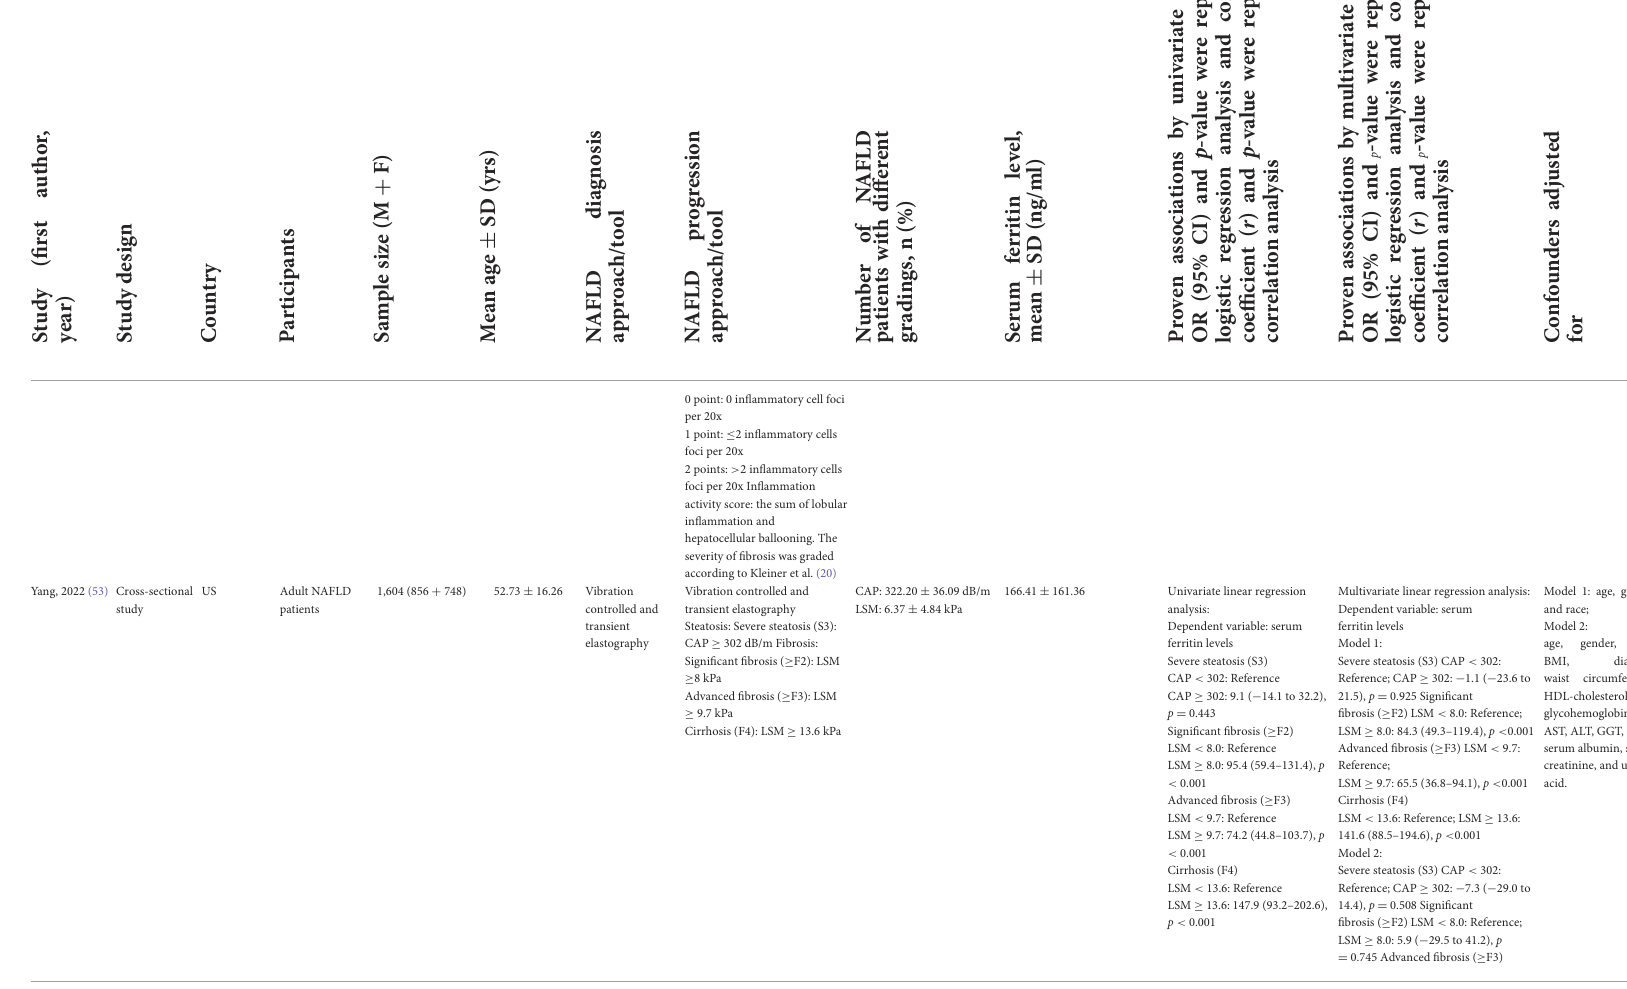
Multivariatelinearregressionanalysis: Dependentvariable:serum ferritinlevels Model1: Severesteatosis(S3)CAP < 302: Reference;CAP ≥ 302: − 1.1( − 23.6to 21.5), p = 0.925Significant LSM ≥ 9.7:65.5(36.8–94.1), p < 0.001 Cirrhosis(F4) LSM < 13.6:Reference;LSM ≥ 13.6: 141.6(88.5–194.6), p < 0.001 Model2: Severesteatosis(S3)CAP < 302: Reference;CAP ≥ 302: − 7.3( − 29.0to 14.4), p = 0.508Significant fibrosis( ≥ F2)LSM < 8.0:Reference; LSM ≥ 8.0:5.9( − 29.5to41.2), p = 0.745Advancedfibrosis( ≥ F3)